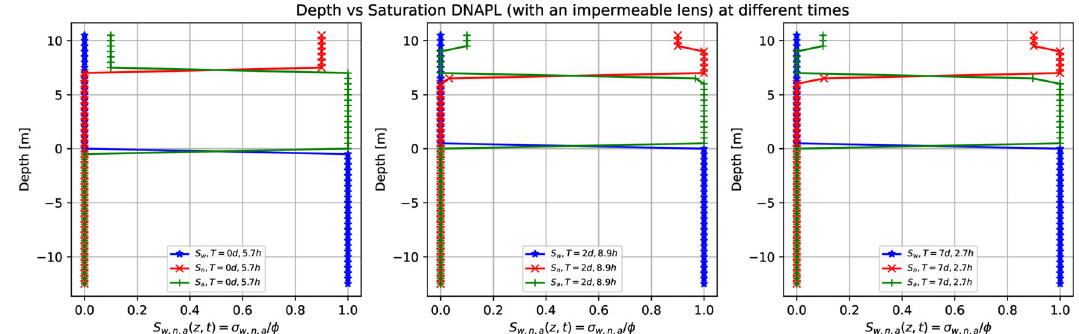
Fig 13. Depth vs. saturation of DNAPL (with an impermeable lens) at different times. Three-dimensional numerical simulation results of a depth as a function of the water saturation S w (blue points), DNAPL saturation S n (red points), and air saturation S a (green points) at various times for a continuous leak of DNAPL of Fig 12 (plane x = 0). The DNAPL leak encounters an impermeable obstacle (depicted in green in Fig 12). The left-hand side shows a sharp front of contaminant saturation (red points) situated in the unsaturated zone at z = [8.0,10.0] m. At later times, (center) after two days and 8.9 hours, the contaminant saturation increases to 1.0 due to an accumulation on top of the impermeable zone while part of it reaches the saturated zone. This situation remains almost invariable for later times (right-hand side) since we plot the x = 0